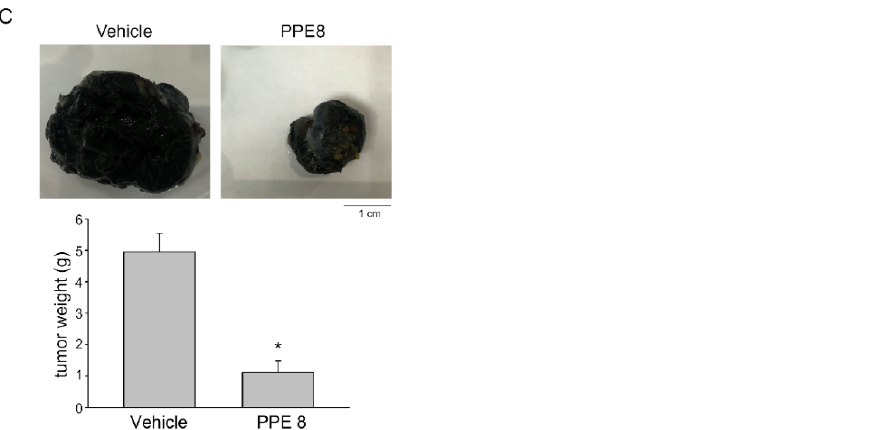
Figure 5. PPE8 suppressed B16F10 melanoma xenograft growth in vivo. ( A ) MDA-MB-231, HCT116, B16F10, Hacat, or Hs68 cells were treated with indicated concentrations of PPE8 for 24 h. MTT assay was employed to determine cell viability. Values represent the mean ± S.E.M. of six independent experiments performed in duplicate. *p < 0.05, compared with the control group ( B ) C57BL/6 mice bearing B16F10 melanoma xenografts were intraperitoneally administrated with vehicle or PPE8 (10 mg/kg/day) for 30 days. Tumor volume was evaluated as described in the “Materials and Methods” section. Values represent the mean ± S.E.M. of six xenografts. ( C ) Mice were sacrificed at the end of the experiment (30-days treatment) and tumors were harvested and weighed. Each column represents the mean ± SEM of six xenografts; * p < 0.05, compared with the vehicle-treated control group; Student’s t-test ( D ) Cryosections of B16F10 xenografts were stained with anti-Ki67 antibody for detecting proliferative cells. Immunohistochemical images shown are representative of six independent experiments with similar results. Each column represents the mean ± SEM of six independent experiments; * p < 0.05, compared with the vehicle-treated control group; Student’s t-test ( E ) We examined body weights of the C57BL/6 mice every 3 days within 30 days of treatment. Values represent the mean ± SEM of six mice.